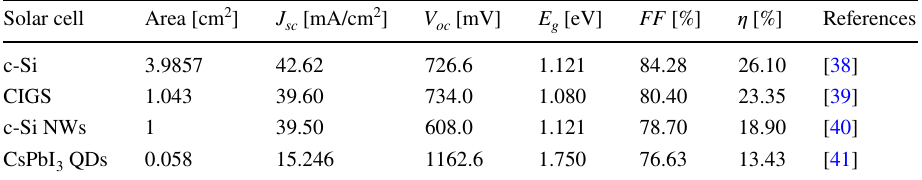
Table 3 Solar cells’